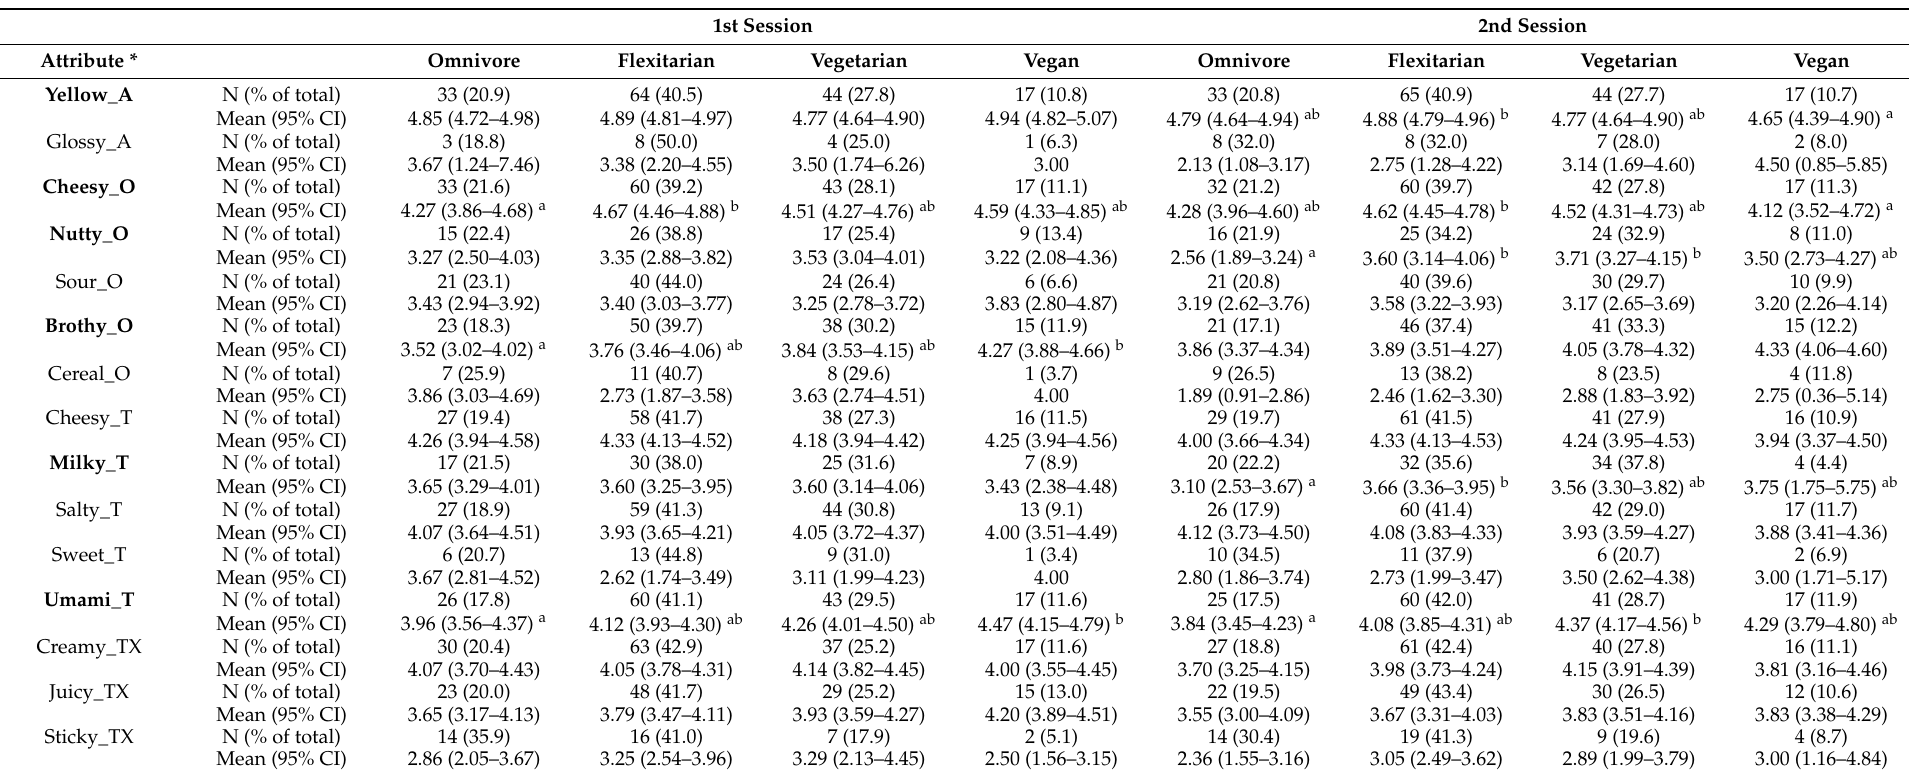
Table 3. RATA attribute assessment of plant-based cheese in two sessions on a 5-point scale, with different shares of 159 participants. Significant differences could be calculated for the attributes in bold